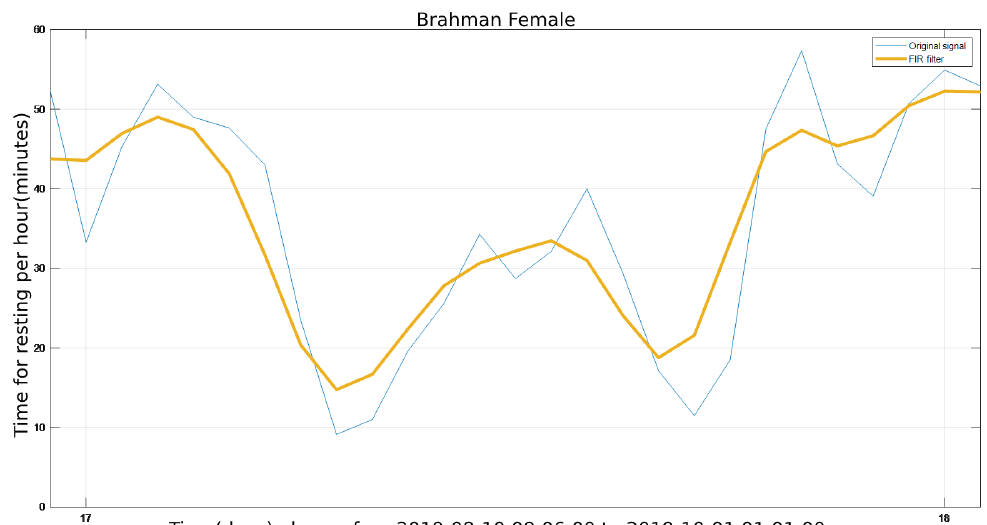
Figure 9. The single resting cycle after the FIR filter.